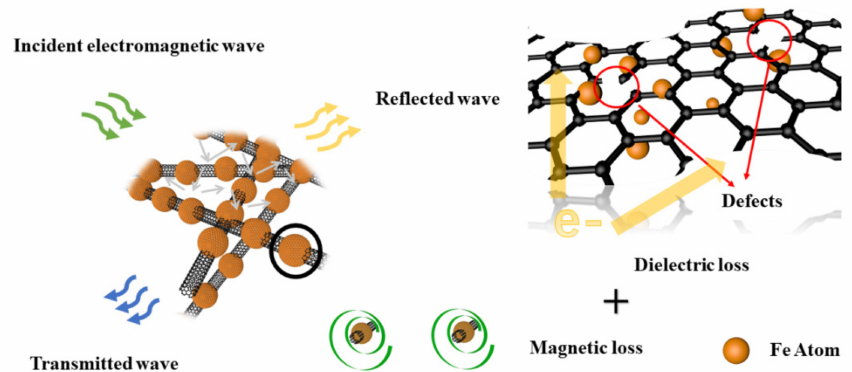
Figure 12. The absorbing mechanism of Fe 3 O 4